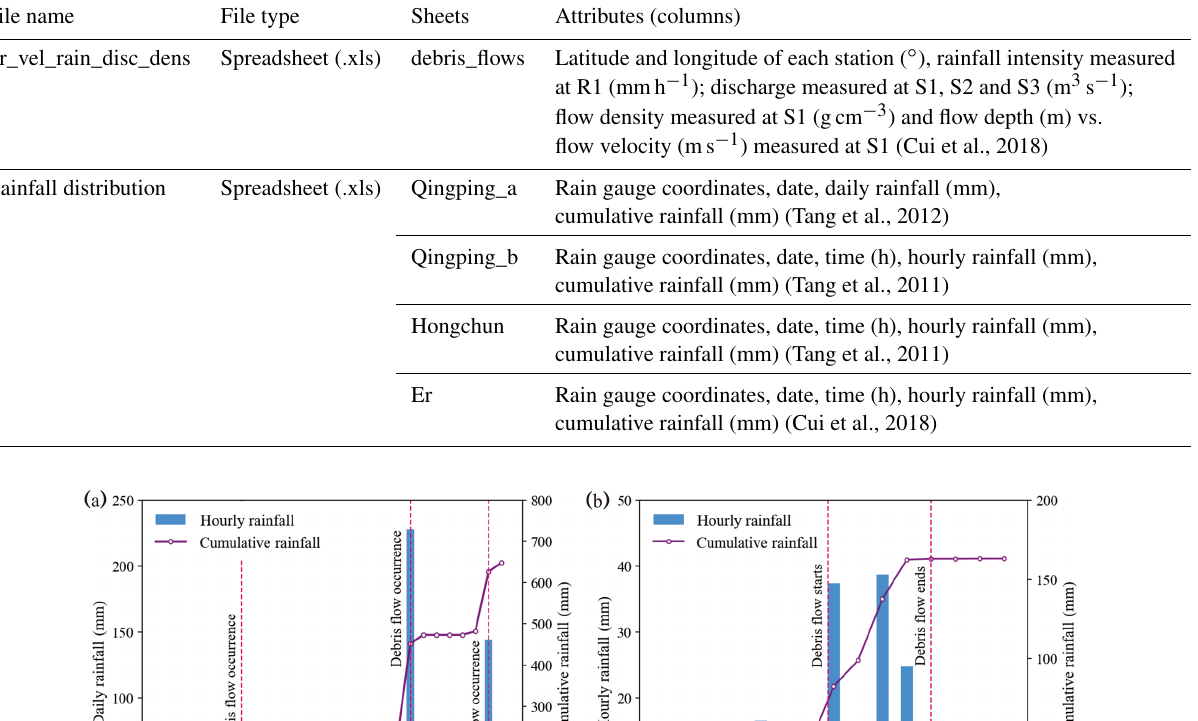
Table 7. Released information on some well-monitored catchments.